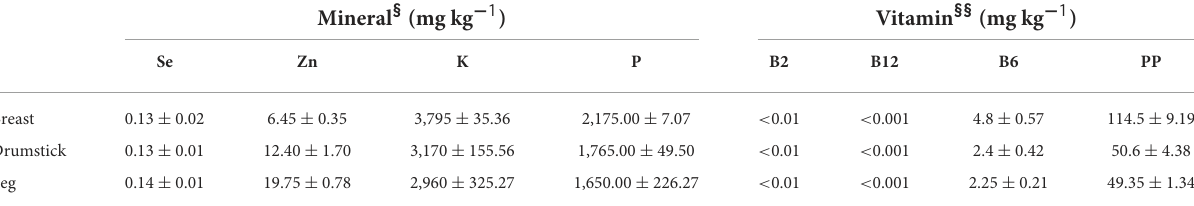
TABLE 2 Minerals and vitamins concentration in cuts of chicken meat